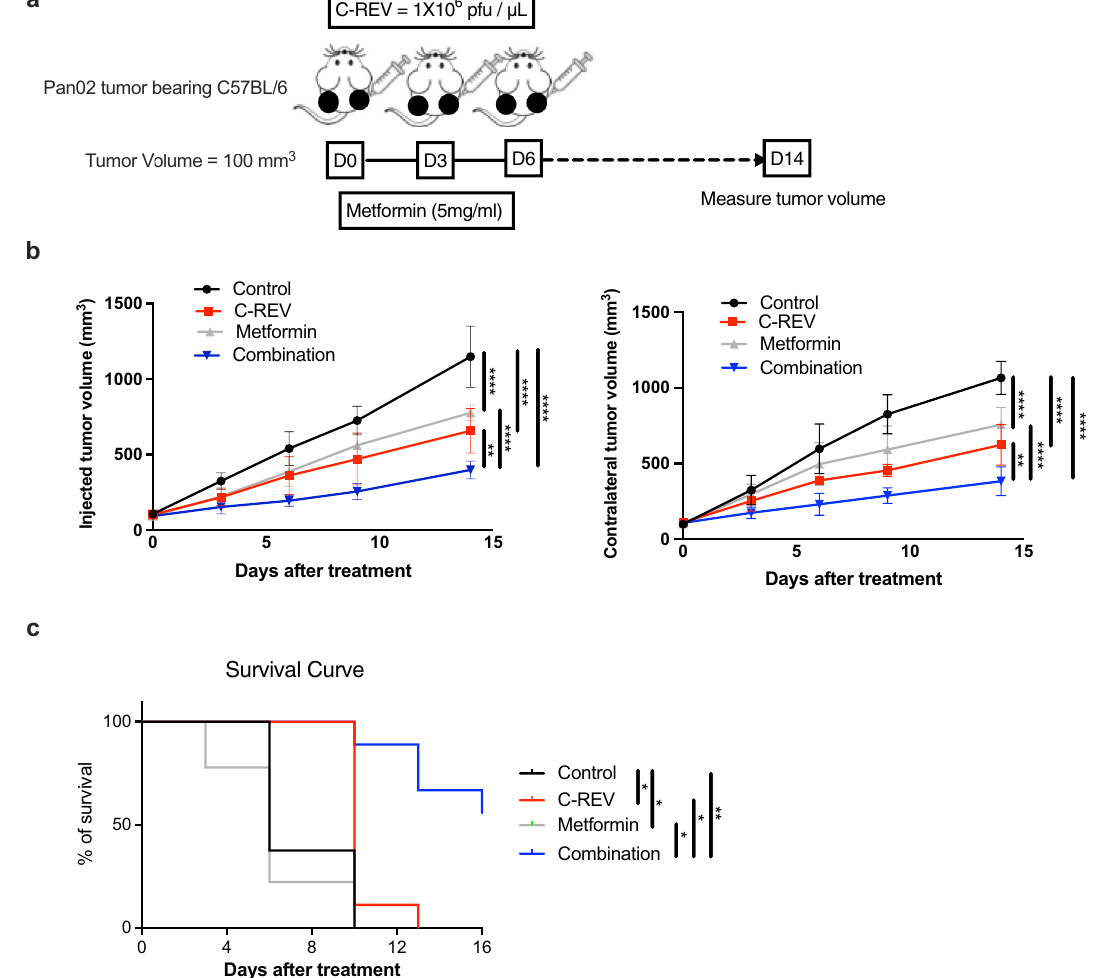
Figure 1. Metformin promotes antitumor activity of C-REV on both the injected and contralateral sides in Pan02 tumor-bearing mice. ( a ) The scheme shows the schedule of C-REV and metformin treatment in C57BL/6 bilateral tumor-bearing mice. Female Six- to seven-week-old C57BL/6 mice were subcutaneously inoculated with Pan02 in both flanks. When tumor size reached around 100 mm 3 , mice were randomly divided into four groups (n = 4 mice) with an equal average tumor volume among the groups. C-REV was injected three times (1 × 10 6 pfu) with three days intervals (D0, D3, and D6) on only one side (injected side) and metformin was continuously supplied in the drinking water (5 mg/ml) after C-REV treatment. Tumor sizes on both sides of tumor were measured twice a week. This experiment was conducted four times, yielding similar results. ( b ) Representative tumor growth in Pan02 tumor models after treatment. Data are presented as mean ± SD. Two- way ANOVA followed by Tukey’s multiple comparisons tests were performed. ( c ) Representative mouse survival in Pan02 tumor models after treatment (n = 9). For the evaluation of survival, the death event was defined when the total tumor size reached 2000 mm 3 . Survival analysis was performed using the Kaplan–Meier method. The log-rank test was used for the statistical comparison of the curves. ( b ) and ( c ) are from different experiments. * p < 0.05, ** p < 0.01, **** p <